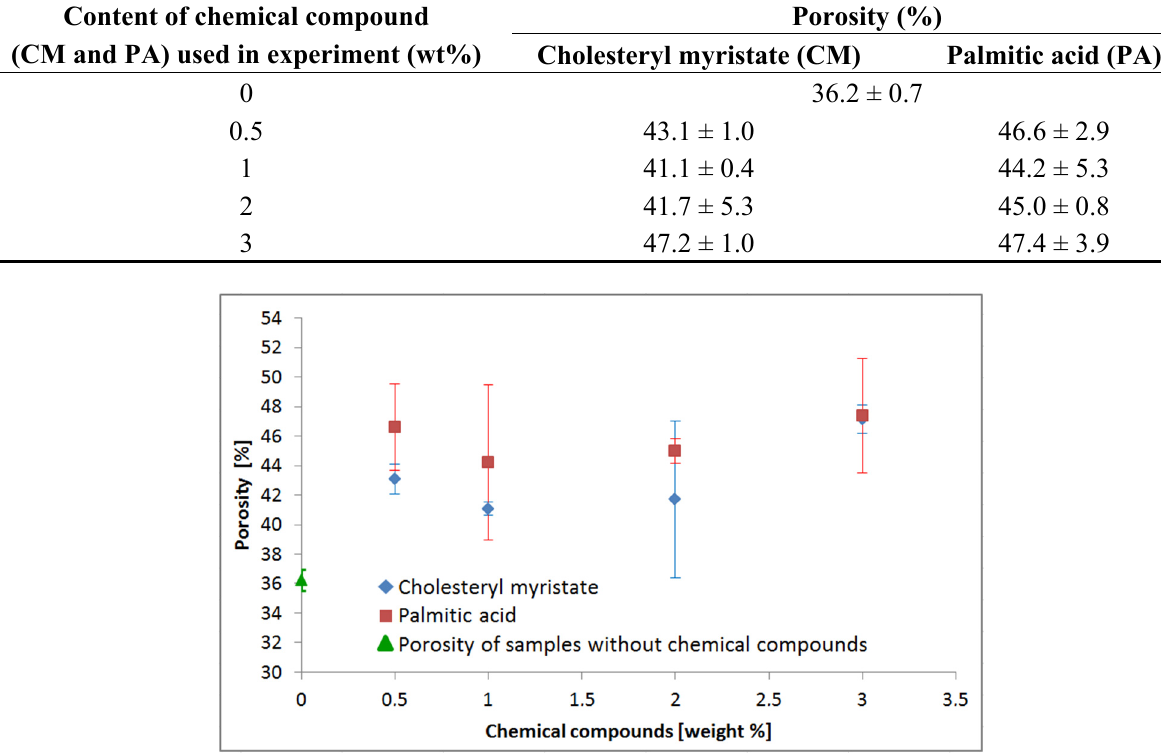
Figure 3. Influence of chemical-compound additive contents on the final porosity of